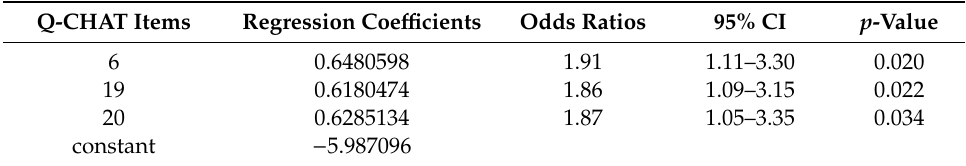
Table 3. Results of the multivariate logistic regression analysis stepdown procedure on the association between diagnosis of ASD or BAP at 36 months and Q-CHAT items significantly associated at the bivariate logistic regression at 12 months of age (Items 5, 6, 10, 19 and